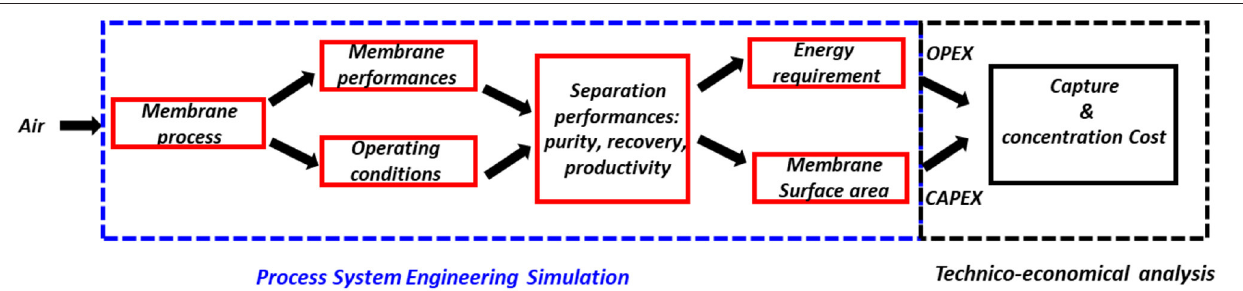
FIGURE 2 | Sketch of the overall framework of the study. The separation performances of a capture process for DAC (i.e., dotted blue rectangle, which corresponds to the capture box in Figure 1 ), based on a single-stage membrane separation unit, are explored. The impact of membrane performances and operating conditions will be systematically covered in order to evaluate the specific energy requirement and production capacity of a membrane process fed by air. These key data are needed for further technico-economical studies of DAC (black box on the right) but this task will not be performed